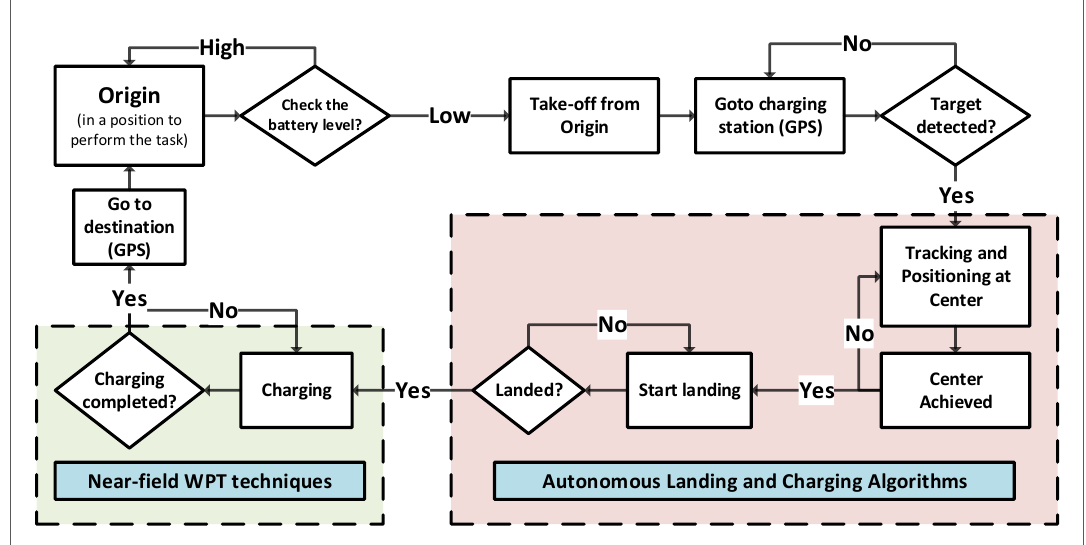
Figure 1. Autonomous landing and wireless charging algorithms for